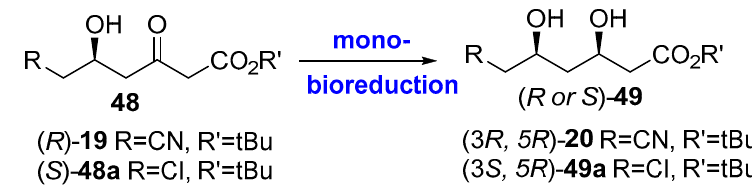
Figure 12. Bio-reductions to produce chiral building blocks for statins.